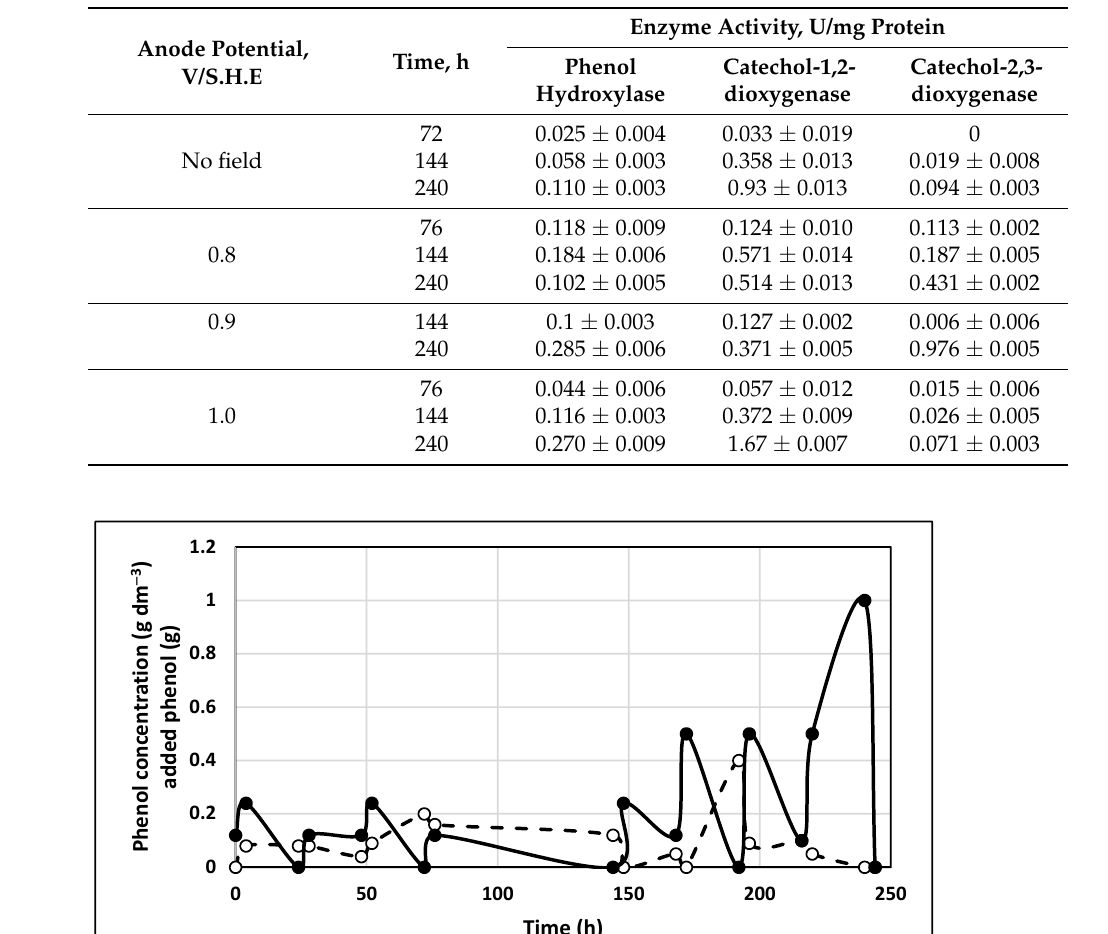
Table 2. Maximum enzyme activities at different anode potentials. Initial phenol concentration, 0.06 g dm − 3 .